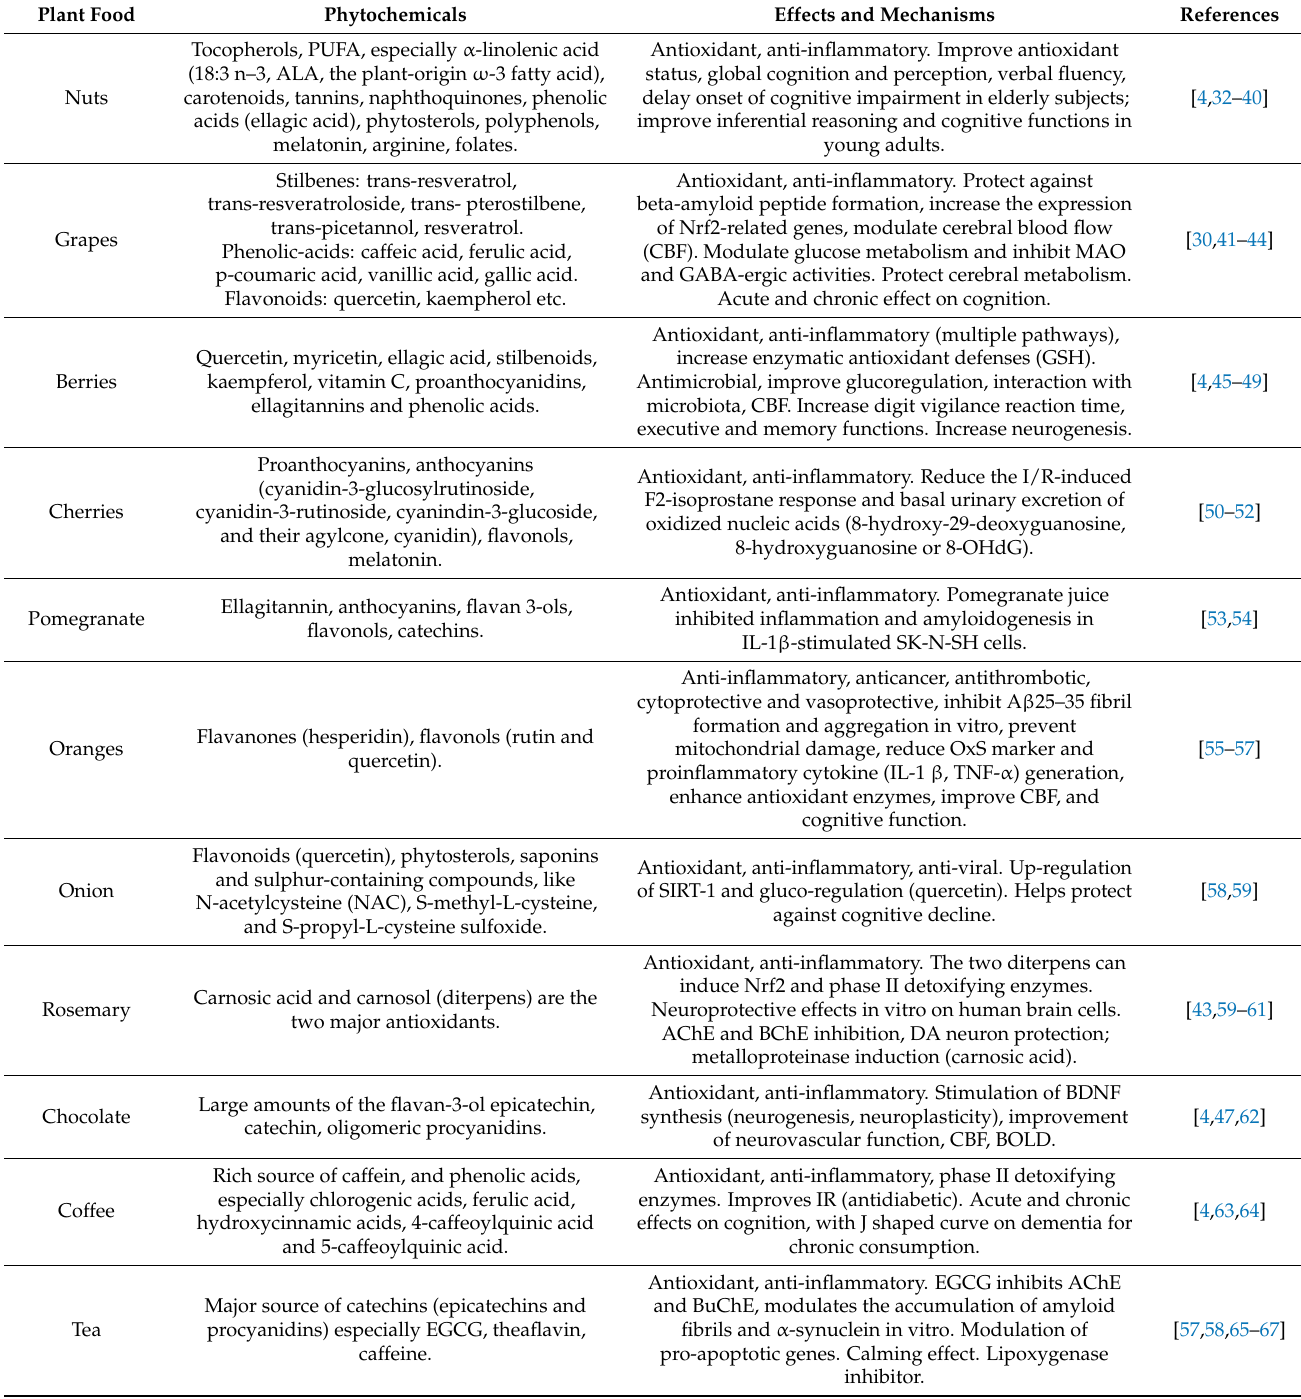
Table 1. The major phytochemicals in dietary plant food (in order of food